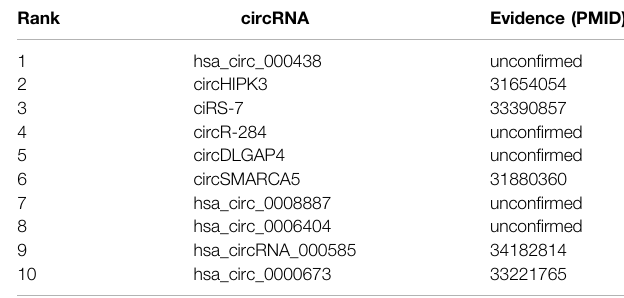
TABLE 5 | Top 10 candidate circRNAs related to cholangiocarcinoma.